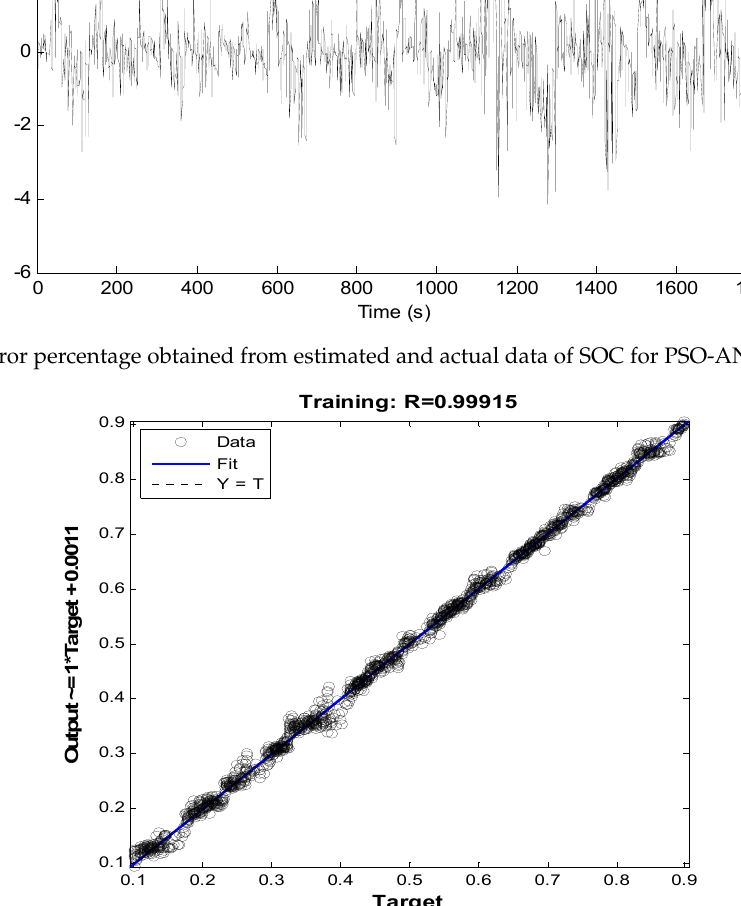
Figure 9. Regression plot of LSA-ANN